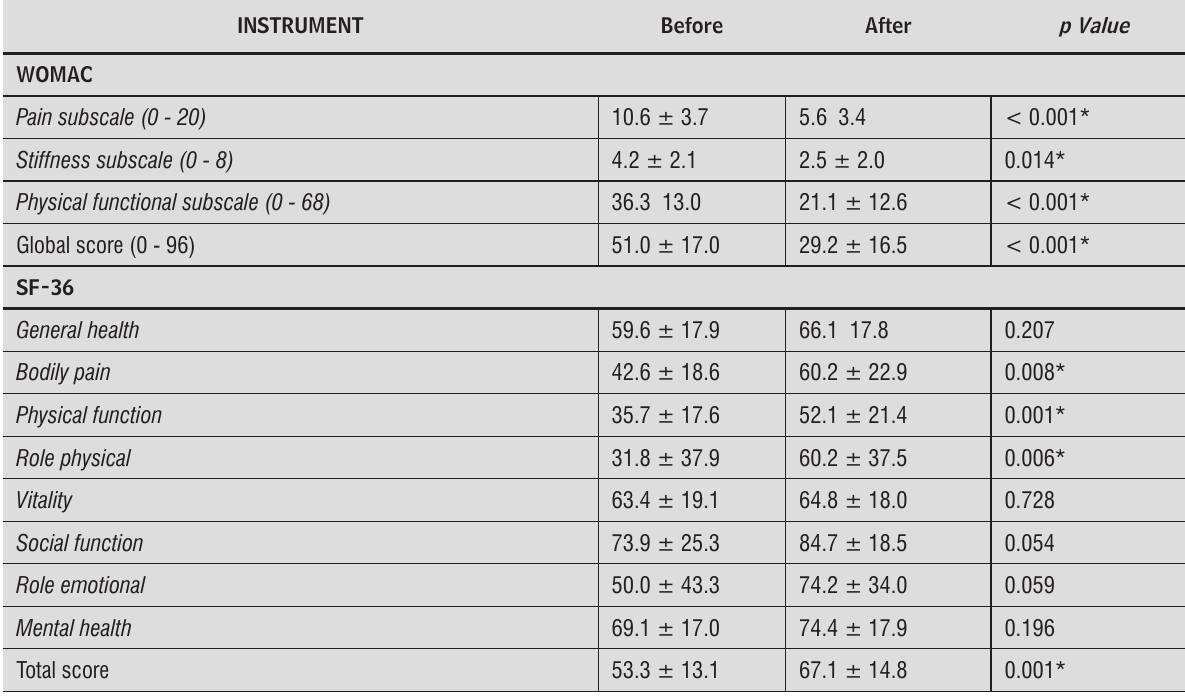
Table 2 - Changes in functional performance and quality of life in patients with osteoarthritis of the knee INSTRUMENT Before After p